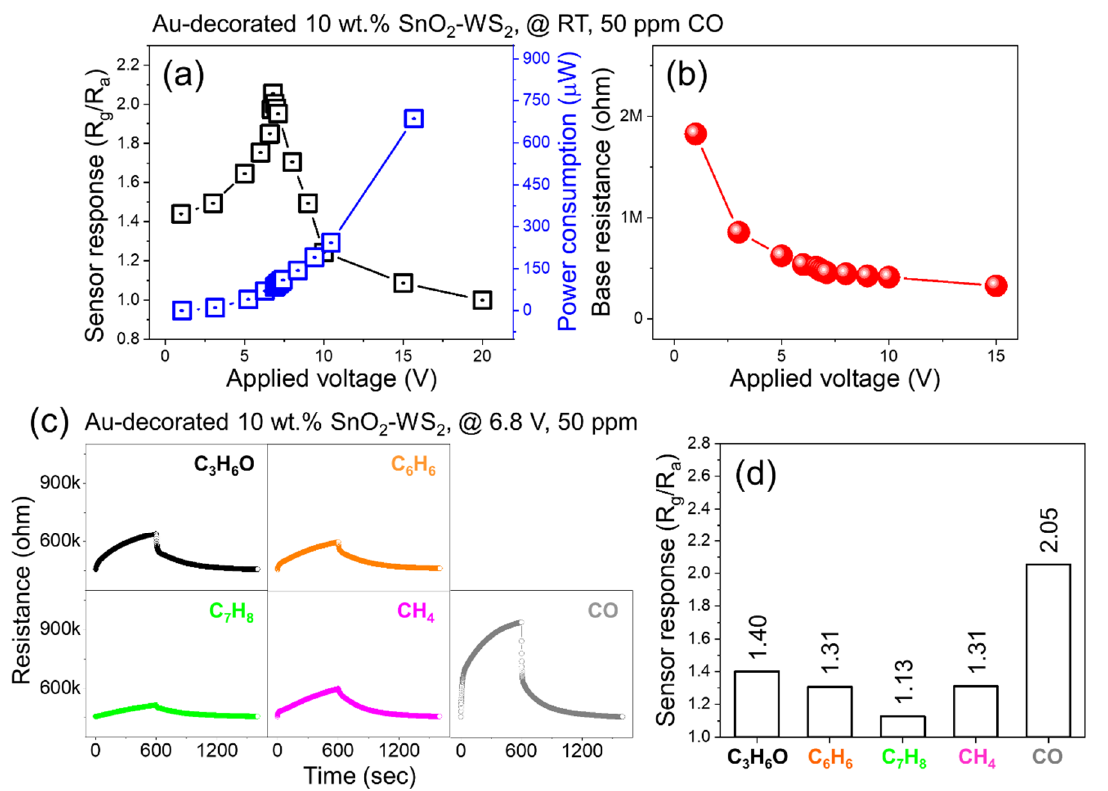
Figure 7. ( a ) Sensor response versus applied voltage for Au-decorated 10 wt% SnO 2 –WS 2 gas sensor at 20 ◦ C to 50 ppm CO gas. ( b ) Corresponding base resistance and power consumption versus applied voltage. ( c ) Dynamic resistance curves of 10 wt% SnO 2 –WS 2 gas sensor to 50 ppm of different gases at 20 ◦ C and under fixed 6.8 V applied voltage. ( d ) Corresponding selectivity